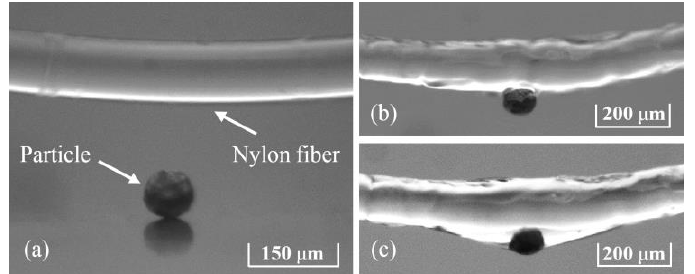
Figure 7. The attachment procedure of the particle to be tested on a nylon fiber, ( a ) the 89 µ m metal particle and the 115 µ m in diameter nylon fiber; ( b ) the initial attachment of the particle on the fiber by glue; and ( c ) the finally attached particle completely surrounded by the glue.